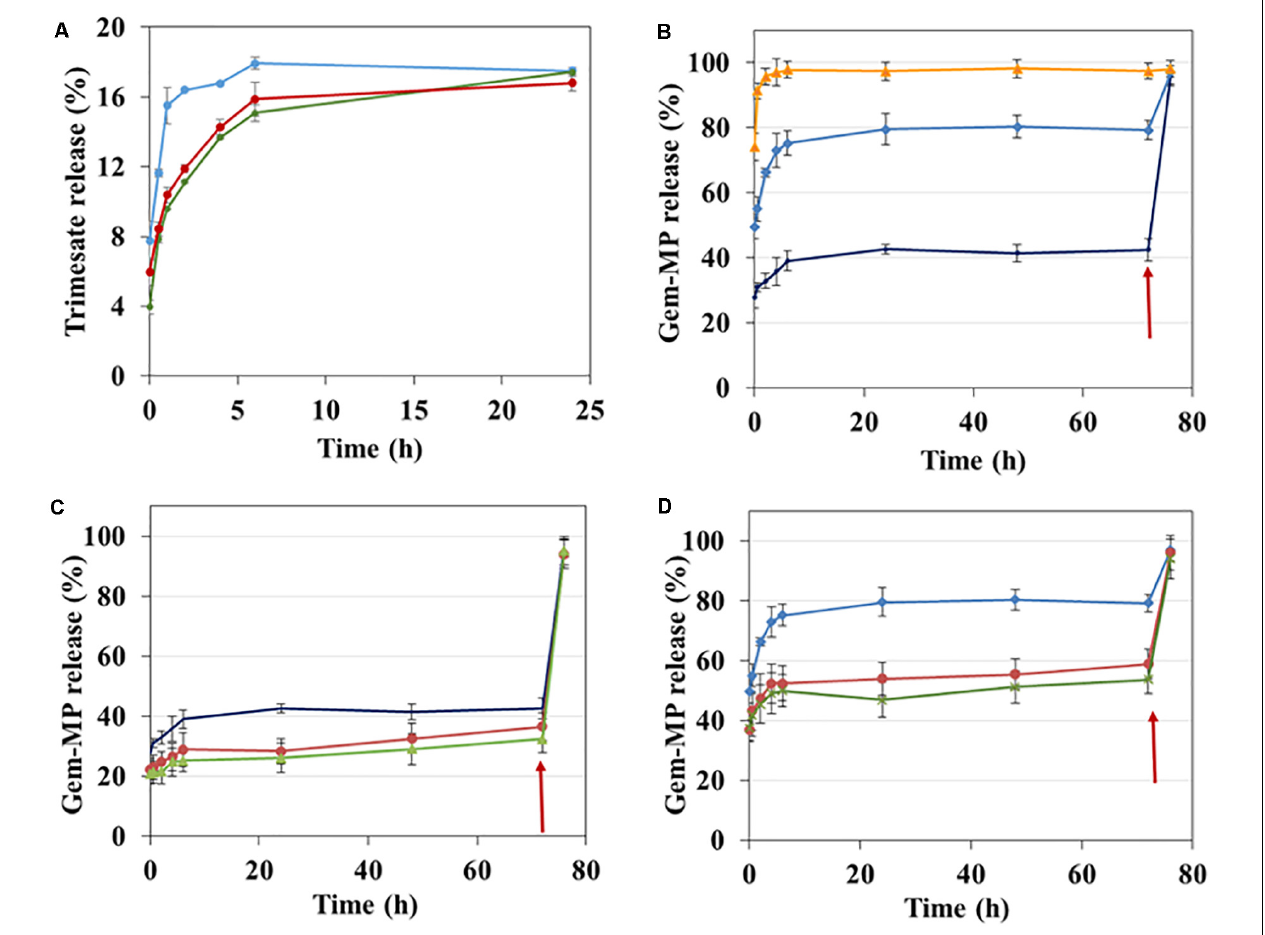
FIGURE 5 | Effect of surface modification on Gem-MP and trimesate release analyzed by HPLC. (A) Trimesate release in 1 mM PBS from nanoMOFs before (blue) and after lipid coating with (red) or without (green) coating with PEG-lipid conjugates after incubation at 37 ◦ C. (B) Gem-MP release from uncoated nanoMOFs in PBS with different molarities (orange: 6 mM, blue: 3 mM; dark blue: 1 mM). Gem-MP release in 1 mM (C) or 3 mM (D) PBS from nanoMOFs before (blue/dark blue) and after lipid coating with (red) or without (green) coating with PEG-lipid conjugates. In all cases (B–D) , phosphate concentration was adjusted to 10 mM after 72 h incubation at 37 ◦ C (red arrows), followed by further incubation for 4 h at 37 ◦